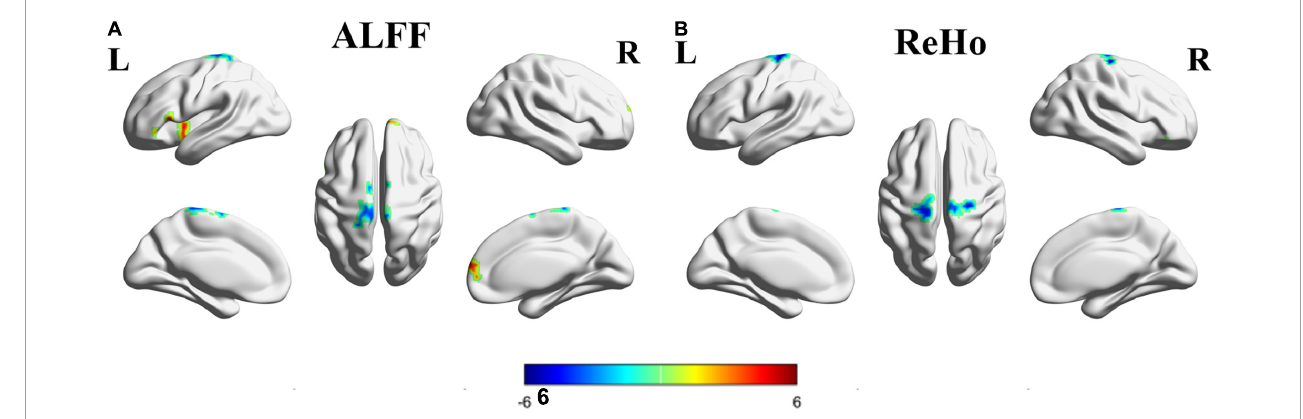
FIGURE2 Brain regions with significantly different ALFF and ReHo values between the overseas group and the local group. Colors (blue-red) represent decreased and increased ALFF or ReHo values. L, left; R, right; (A) ALFF; (B)